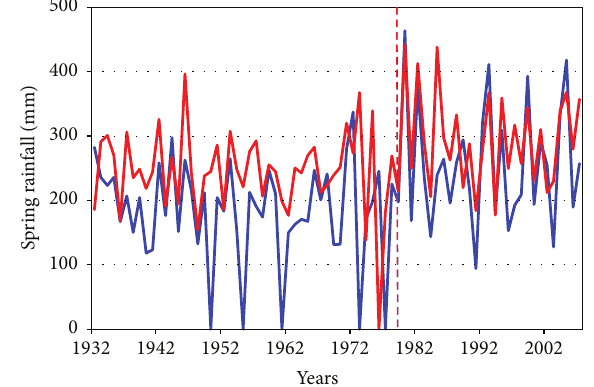
Figure 3: Comparison of temporal variability in the amount of spring rain at the Joliette (agricultural watershed, blue curve) and Saint-Michel-des-Saints (forested watershed, red curve) stations. The vertical bar indicates the year in which the significant change in the mean took place. Zero values actually reflect years for which data are